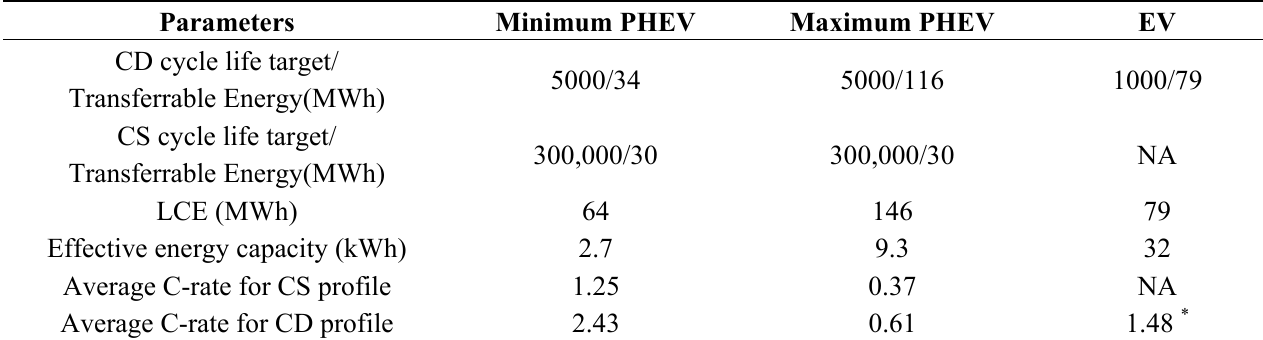
Table 1. USABC goals and Parameters for PHEV and